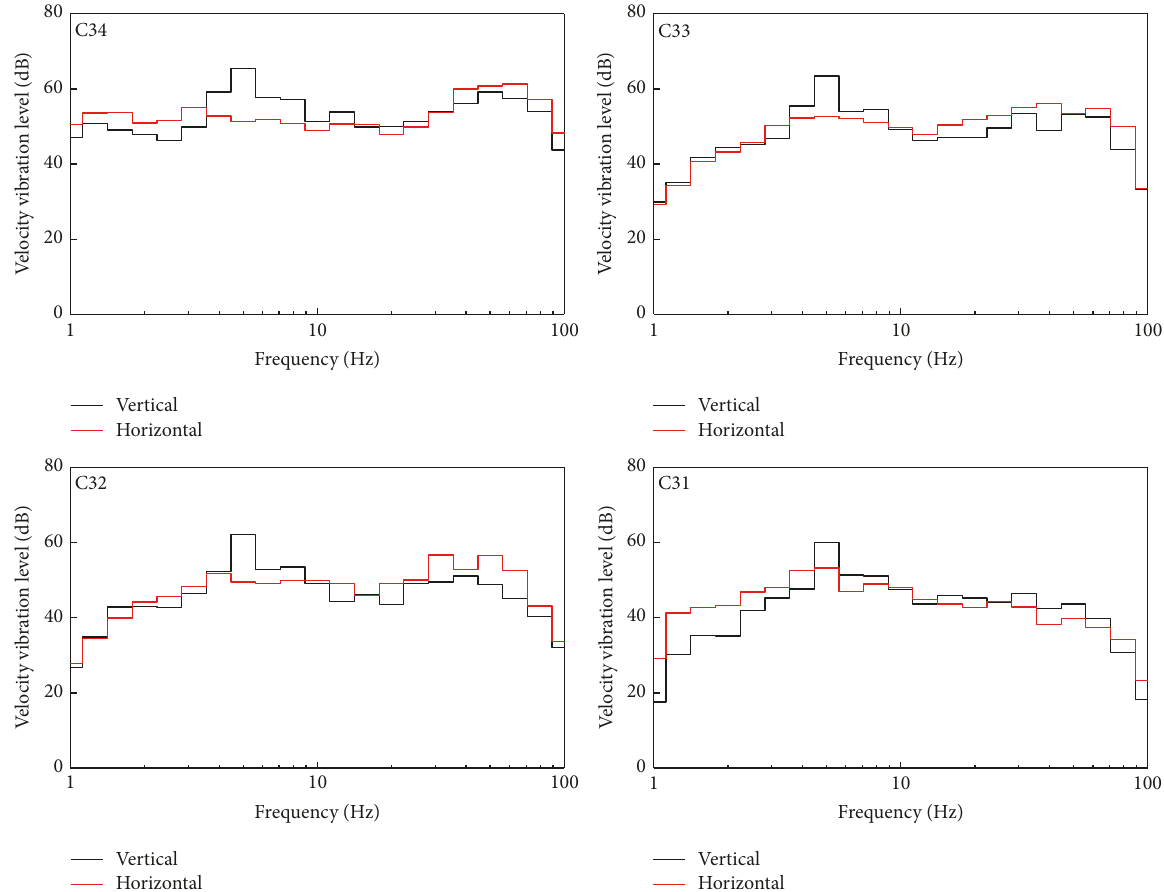
Figure 10: One-third octave band spectra of the embankment surface vibration velocity in vertical and horizontal direction.